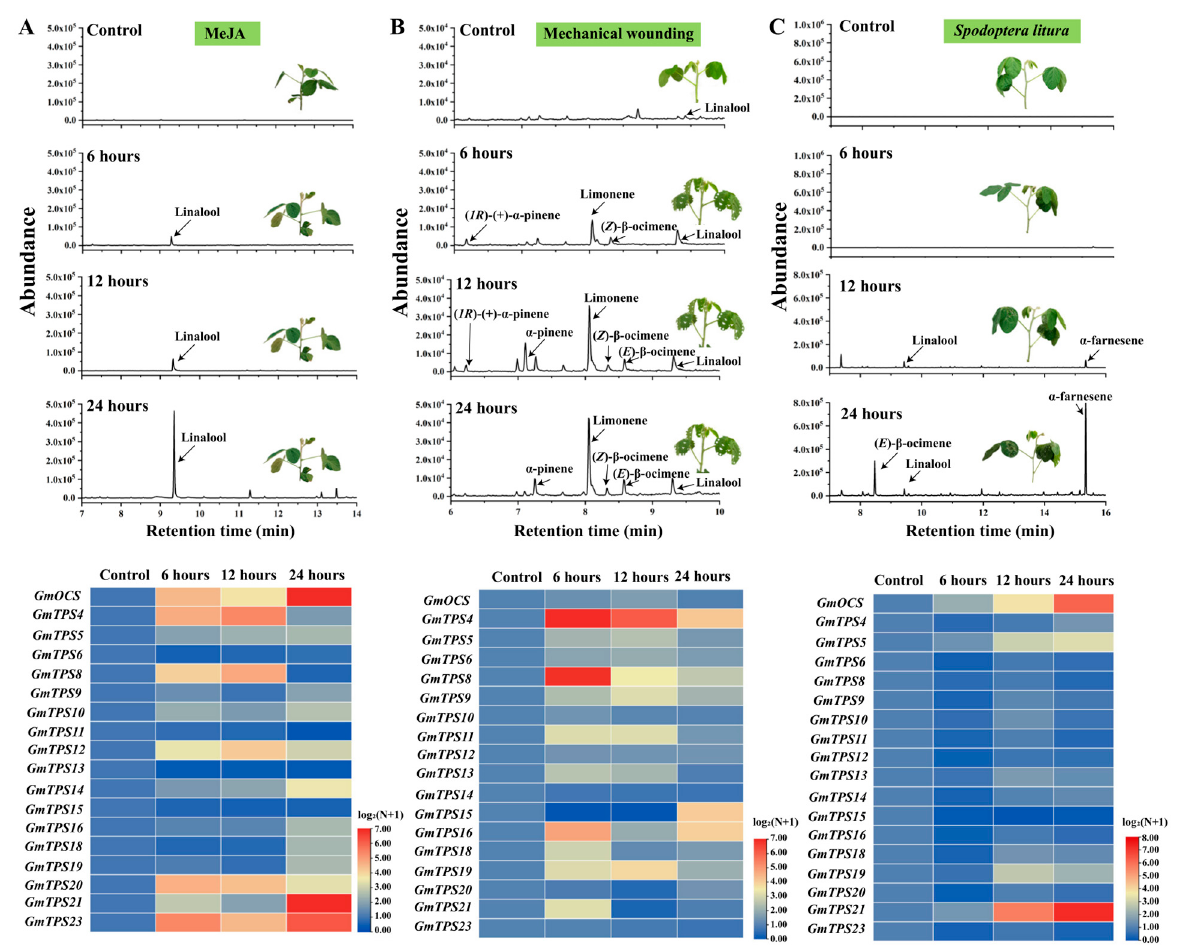
Figure 2. Volatile terpenes and GmTPS expressions response to MeJA, mechanical wounding, or S. litura treatment . ( A ) Volatile terpenes and expressions of GmTPS genes detected in soybean leaves treated with MeJA. ( B ) Volatile compounds and expression of GmTPS genes detected in soybean leaves under mechanical wounding condition. ( C ) Volatile compounds and expression of GmTPS genes induced by S. litura . Healthy and intact leaves without damage were used as control. Each experiment was performed in three biological replicates, and only representative data were provided. The transcripts were normalized by GmACTIN and β -tubulin and compared with the expression level of a specific gene in control. All the data were calculated as log 2 (N + 1). Red and blue boxes indicated high and low expression levels, respectively.